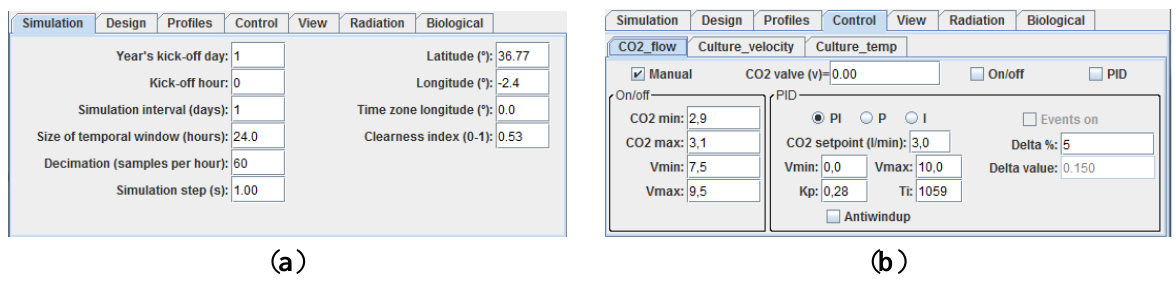
Figure 5. ( a ) Simulation Panel; ( b ) Control